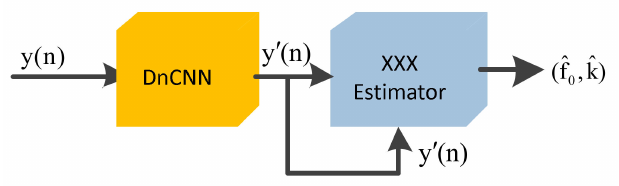
Figure 7. Schematic diagram of DnCNN-XXX.